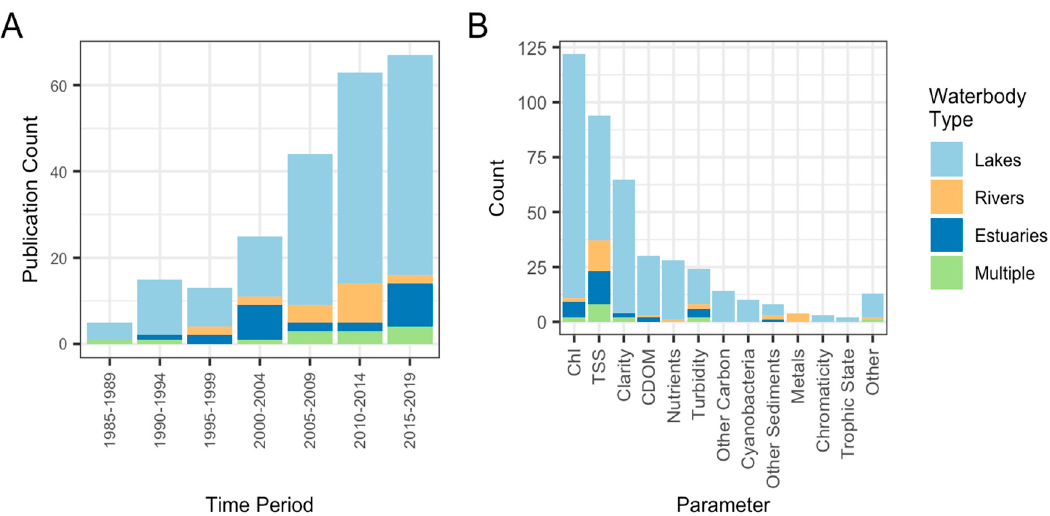
Figure 3. Publication counts within the detailed index binned by time ( A ) and water quality parameter of interest ( B ). Colors represent type of waterbody being researched.